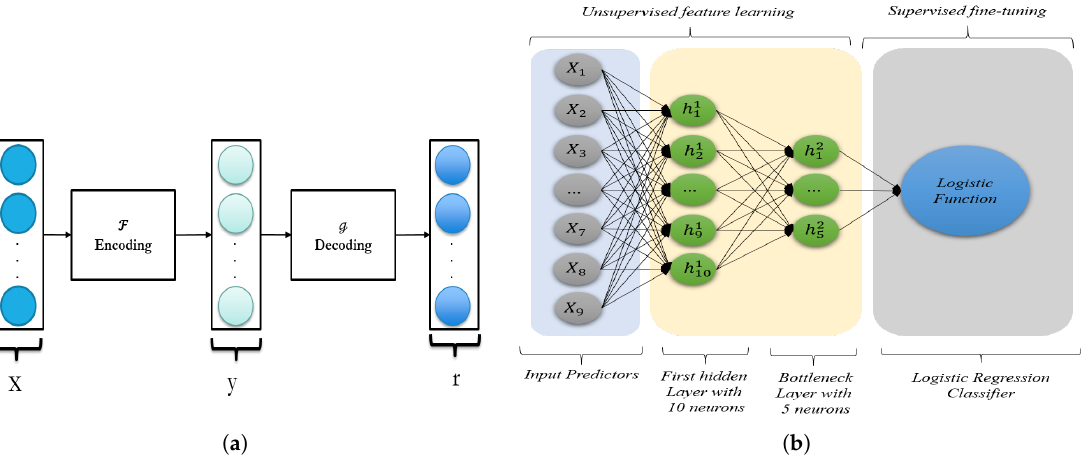
Figure 4. ( a ) The basic structure of an autoencoder includes an input x, which is mapped onto the encoding y via an encoder (function f). This encoding is in turn mapped to the reconstruction r by means of a decoder (function g). ( b ) The structure of the Stacked Denoising Autoencoder (SDAE) used in this